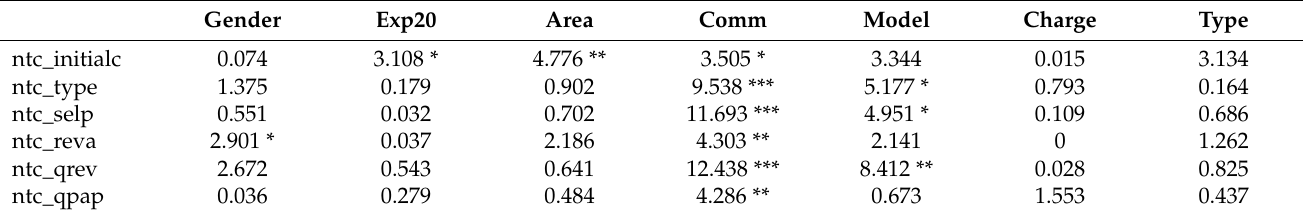
Table 4. Chi-square test for individual bivariate analysis.